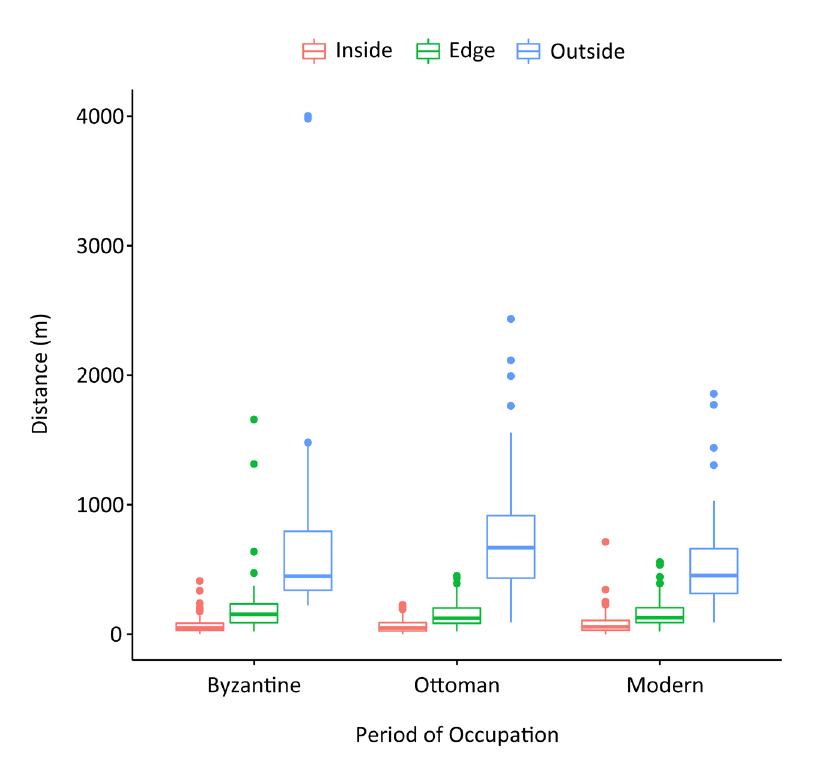
Figure 9. Box plot of distances between all churches in use and their nearest settlement.